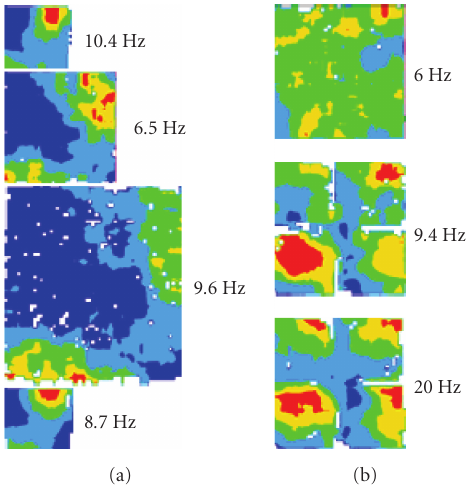
Figure 1: Subicular PC response to size change and barrier inser- tion. Unit a scaled its firing field across all arenas. Unit b replicated its firing in the four rooms across repeated